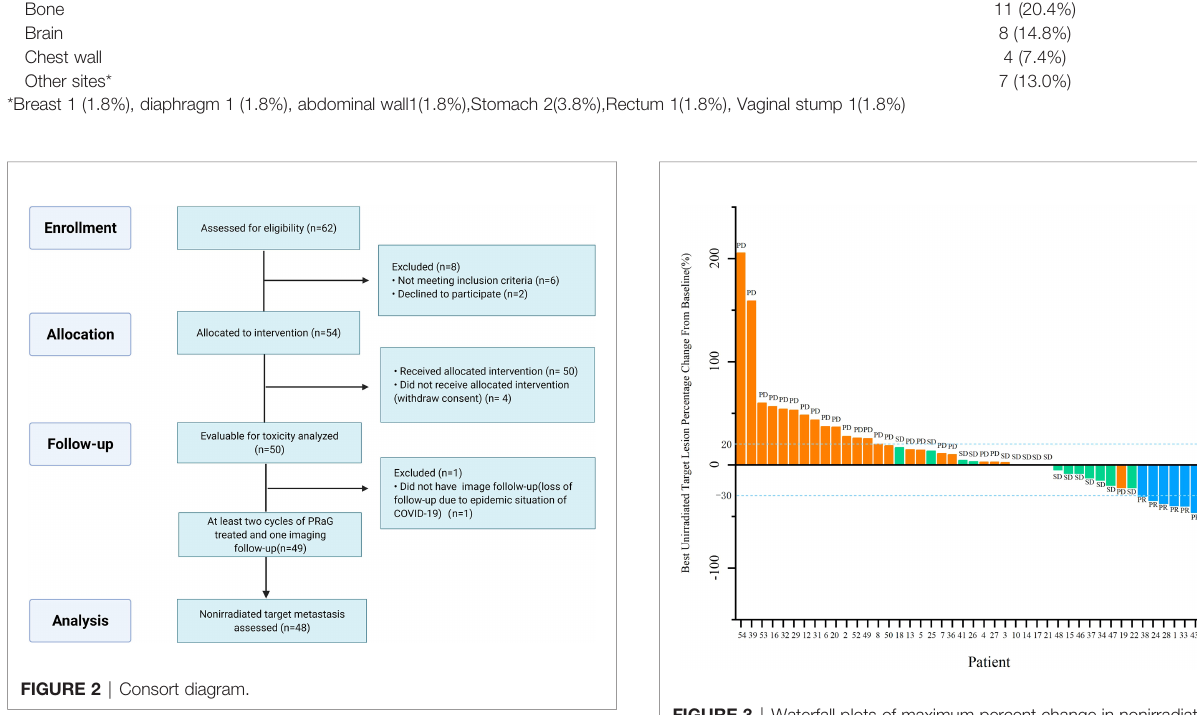
FIGURE 3 | Waterfall plots of maximum percent change in nonirradiated RECIST target